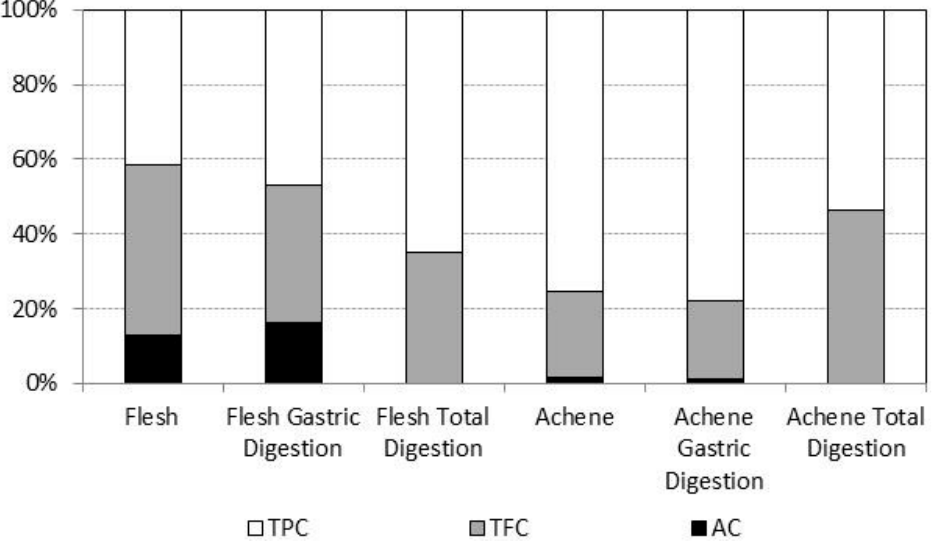
Figure 1. Relative contribution of total flavonoids (TFCs) and anthocyanins (ACs) to total content of phenolic compounds (TPCs) in six different extracts (non-digested flesh, non-digested achenes, flesh and achenes after gastric digestion and flesh and achenes after total digestion).